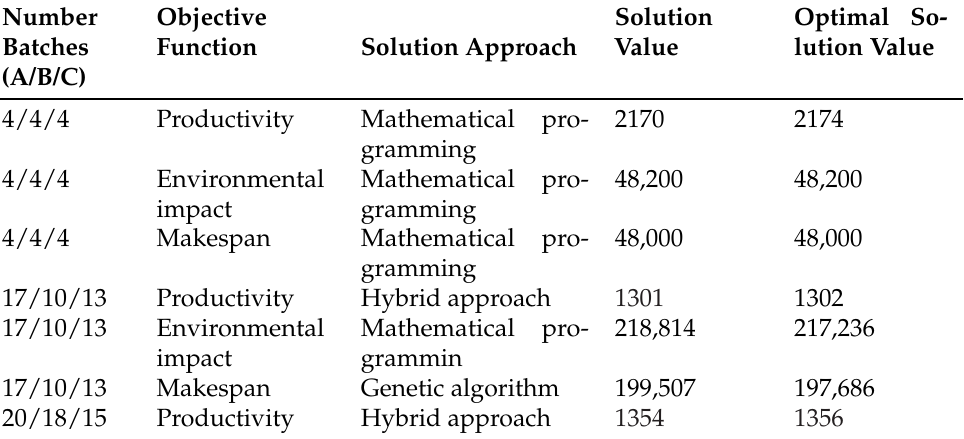
Table 7. Results for different problem instances from the agent-based framework at Polymer